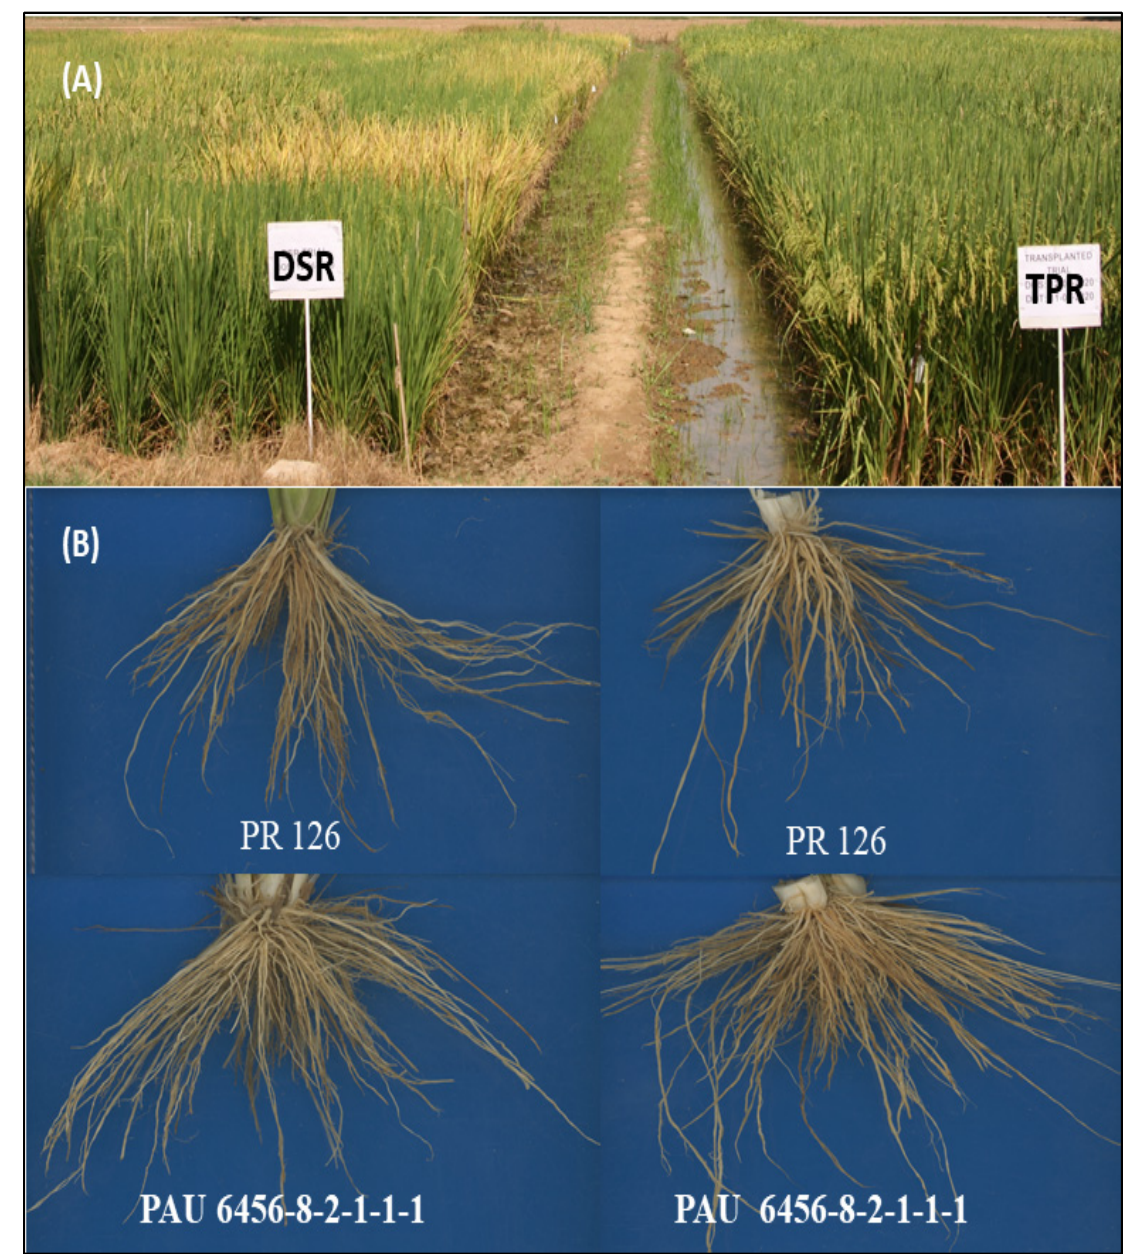
Figure 1. ( A ) The field view of the phenotypic evaluation of the advanced breeding lines under direct seeded cultivation conditions (DSR) and transplanted puddled system of rice cultivation (TPR). ( B ) Root architecture of control check variety (PR126) and one of the selected breeding lines (PAU 6456-8-2-1-1-1) under direct seeded cultivation conditions (DSR, left side) and transplanted Puddled system of rice cultivation (TPR, right side) using WinRhizo PRO root scanner.